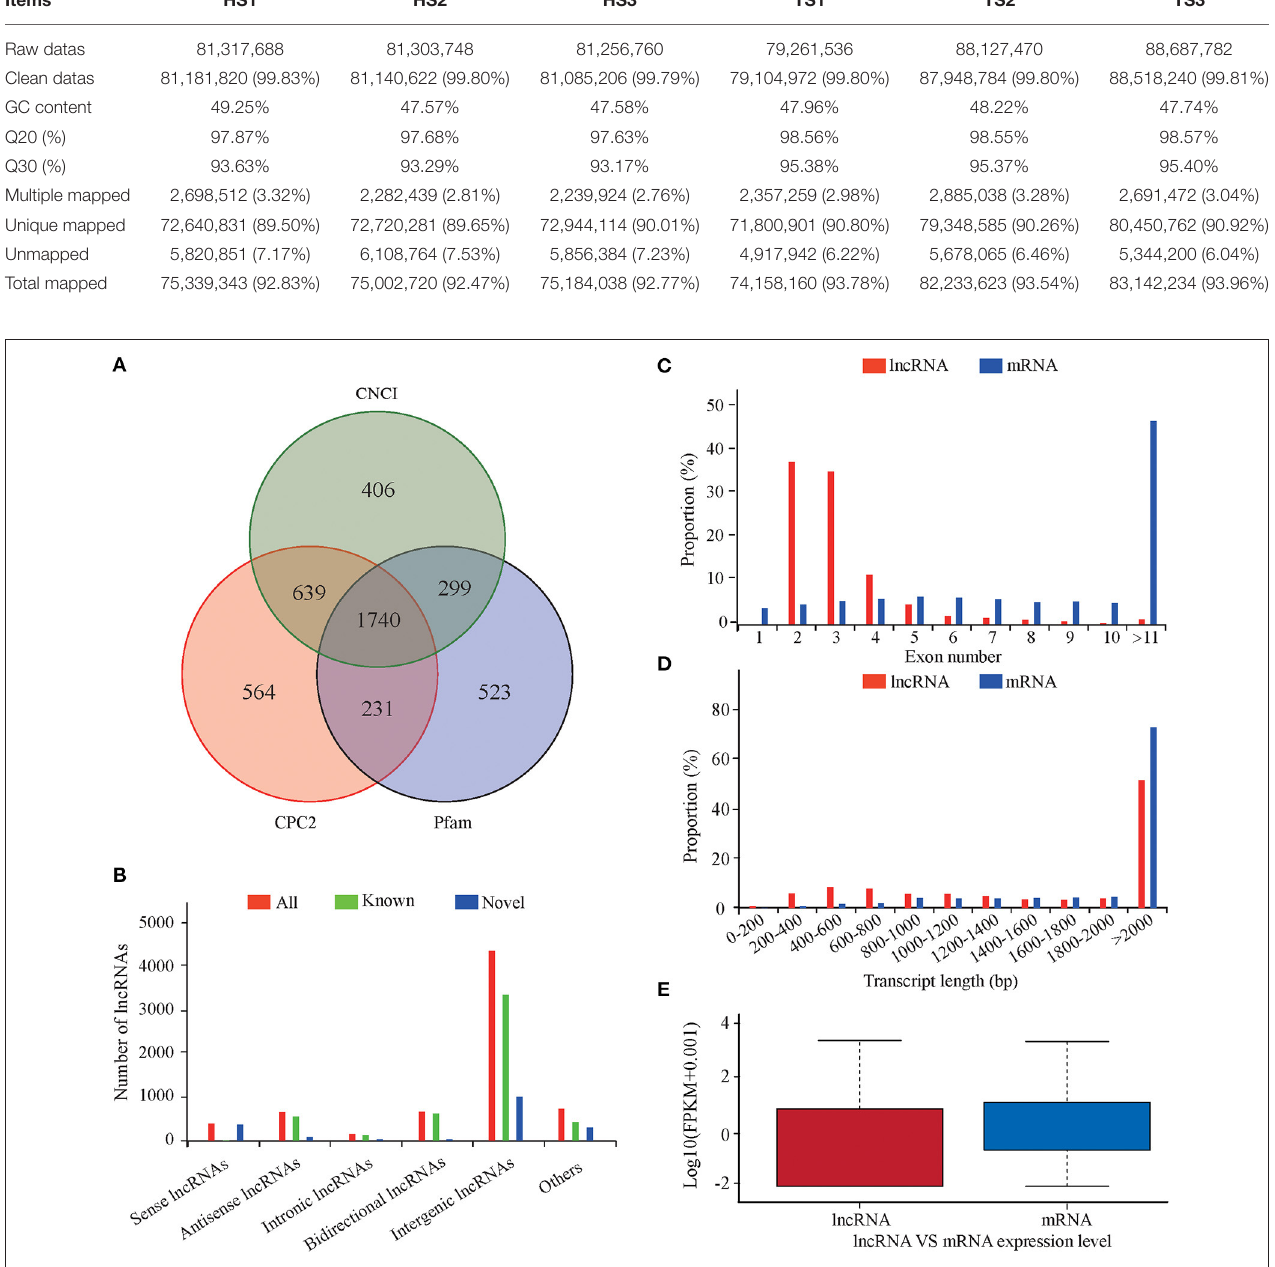
FIGURE 1 | Characteristics of lncRNAs and mRNAs in the lung tissues of sheep at different altitudes. (A) Screening of candidate lncRNAs by CNCI and CPC2. (B) Data on lncRNA transcript types. (C) Distribution of exon numbers in lncRNAs and mRNAs. (D) Length distribution of lncRNAs and mRNAs. (E) Expression levels of lncRNAs and